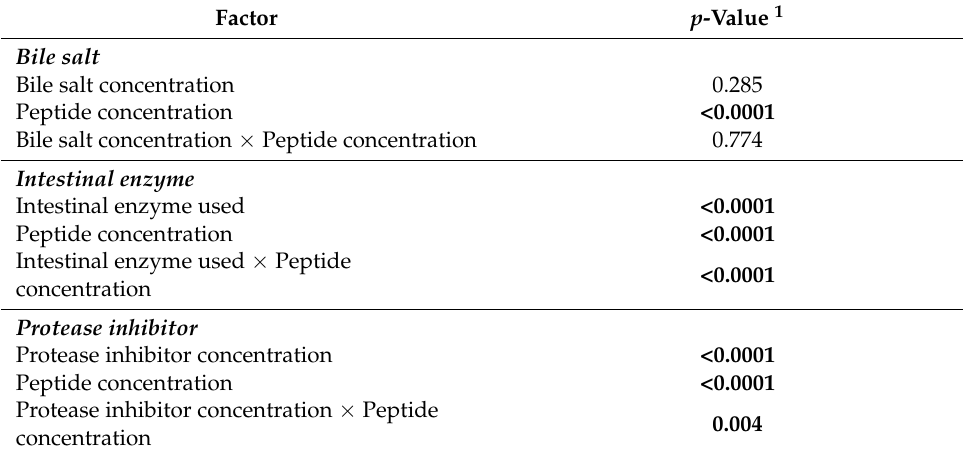
Table 1. Statistical significance of the studied digestion conditions and faba bean peptide concentra- tion on cell viability as assessed by two-way